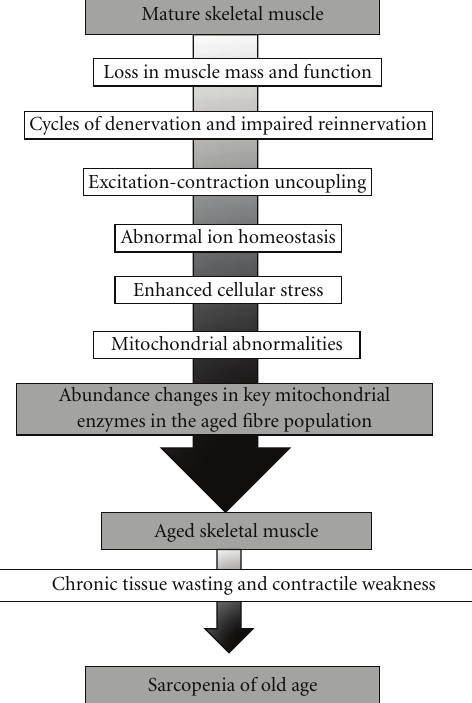
Figure 1: Overview of the multifactorial etiology of sarcopenia. Shown are the main physiological and biochemical events that trigger chronic tissue wasting and severe contractile weakness in senescent skeletal muscles. One of the most striking age-related changes is a drastic alteration in the abundance of mitochondrial